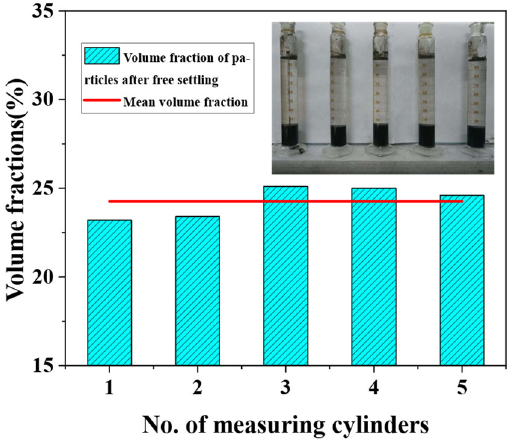
Figure 5. Volume fraction of the sediment layer after free settling of the coal-slurry water.